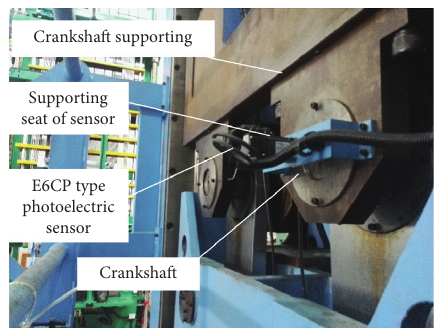
Figure 8: E6CP photoelectric speed sensor measuring tool.